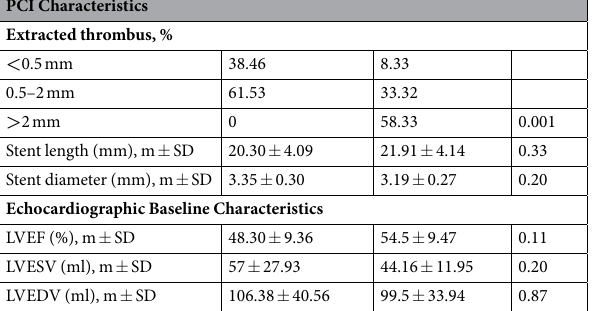
Table 2. Non-clinical characteristics of the two groups. CWP = coronary wedge pressure; LVEF = left ventricular ejection fraction; LVESV = left ventricular end-systolic value; LVEDV = left ventricular end- diastolic value; m = mean; PCI = percutaneous coronary intervention; SD = standard